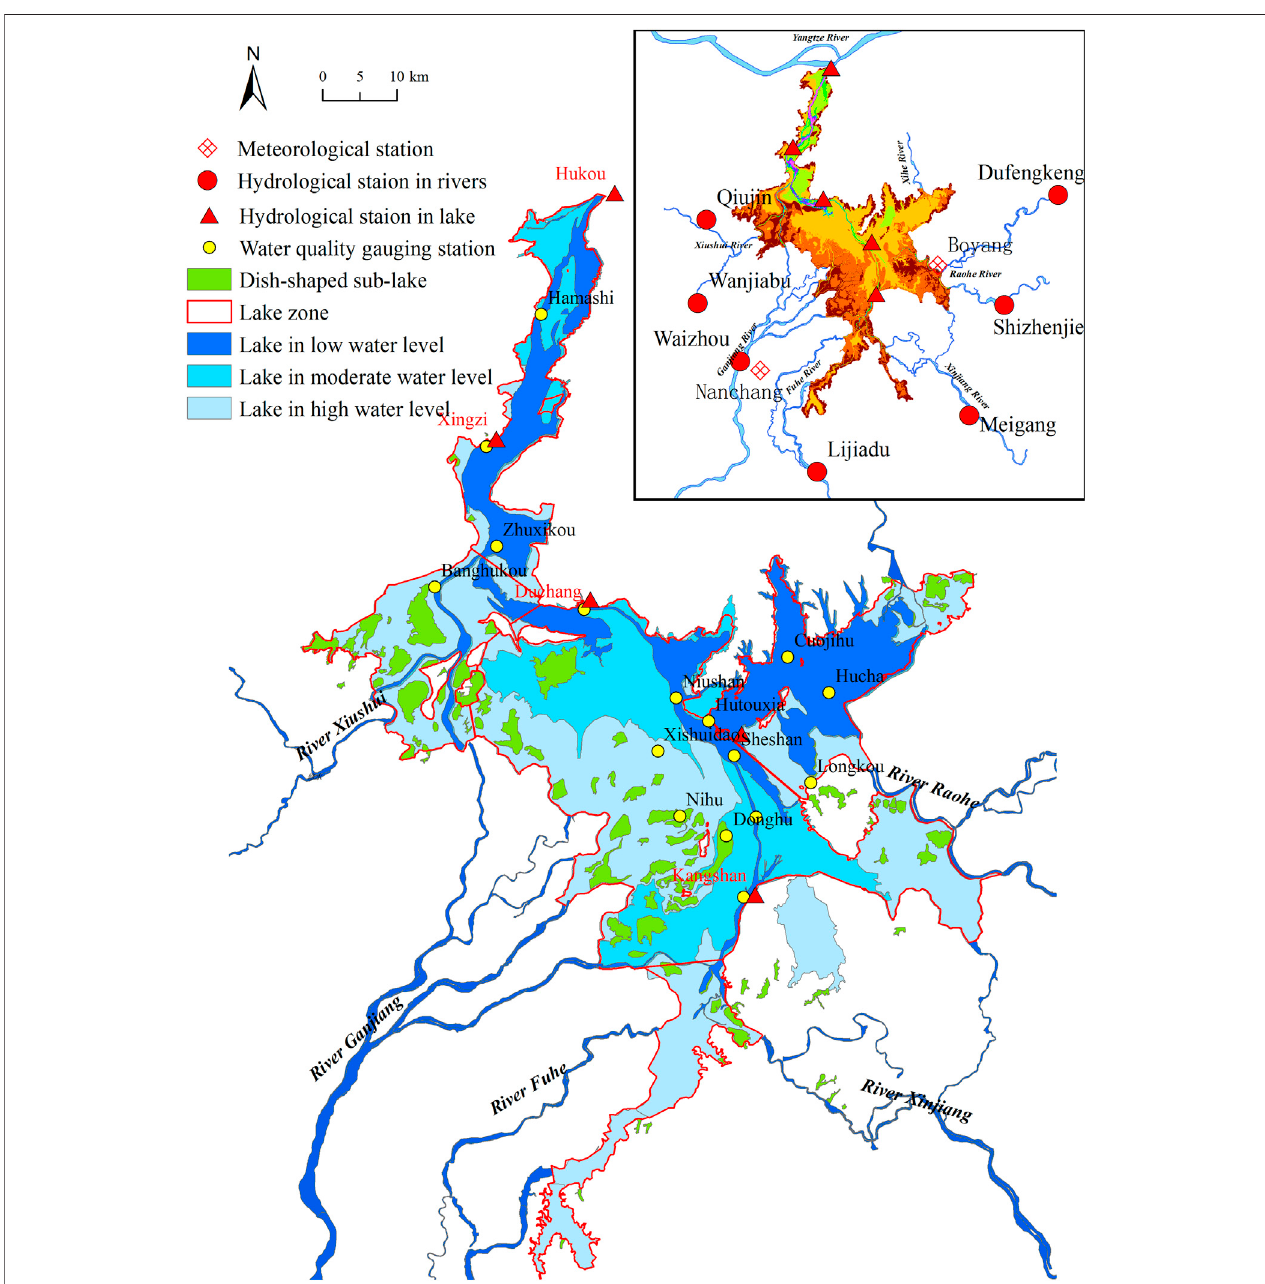
FIGURE 1 | Locations of Lake Poyang, river networks, meteorological stations, hydrological stations in lake and rivers, water quality gauging stations, and the division of lake zones.